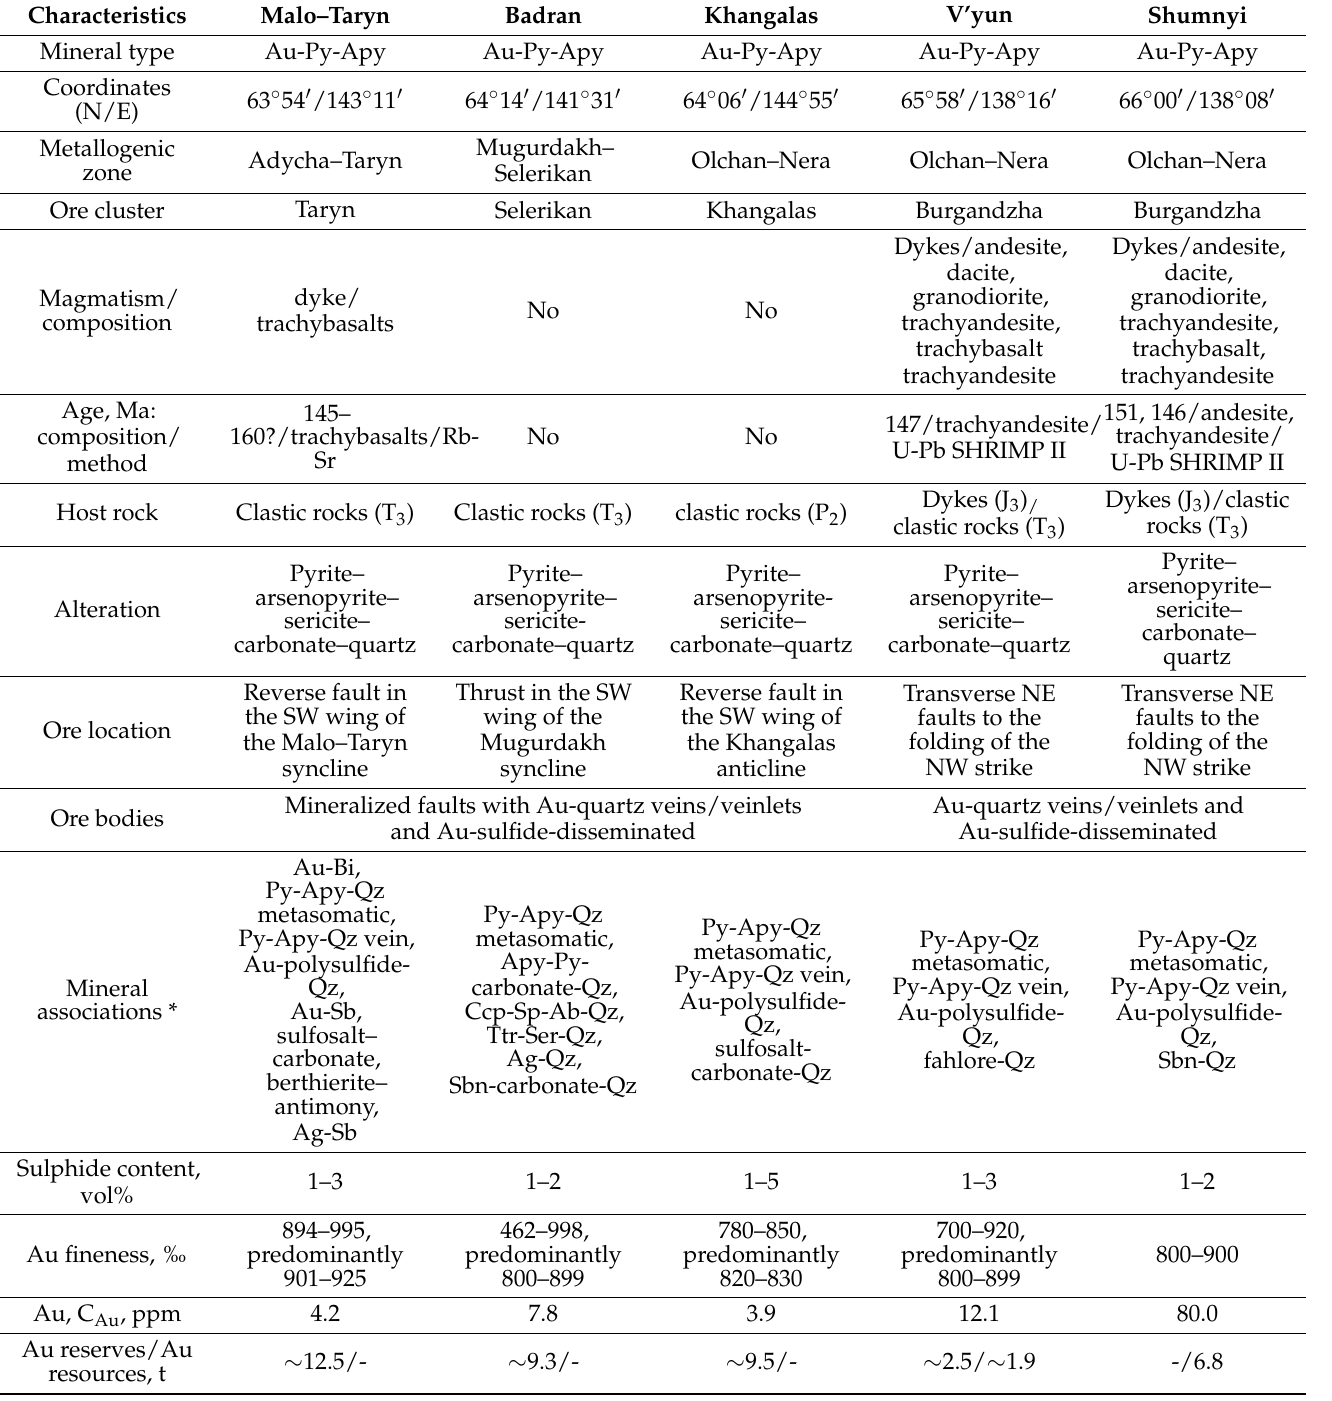
Table 1. General characteristics of the studied OGDs, central